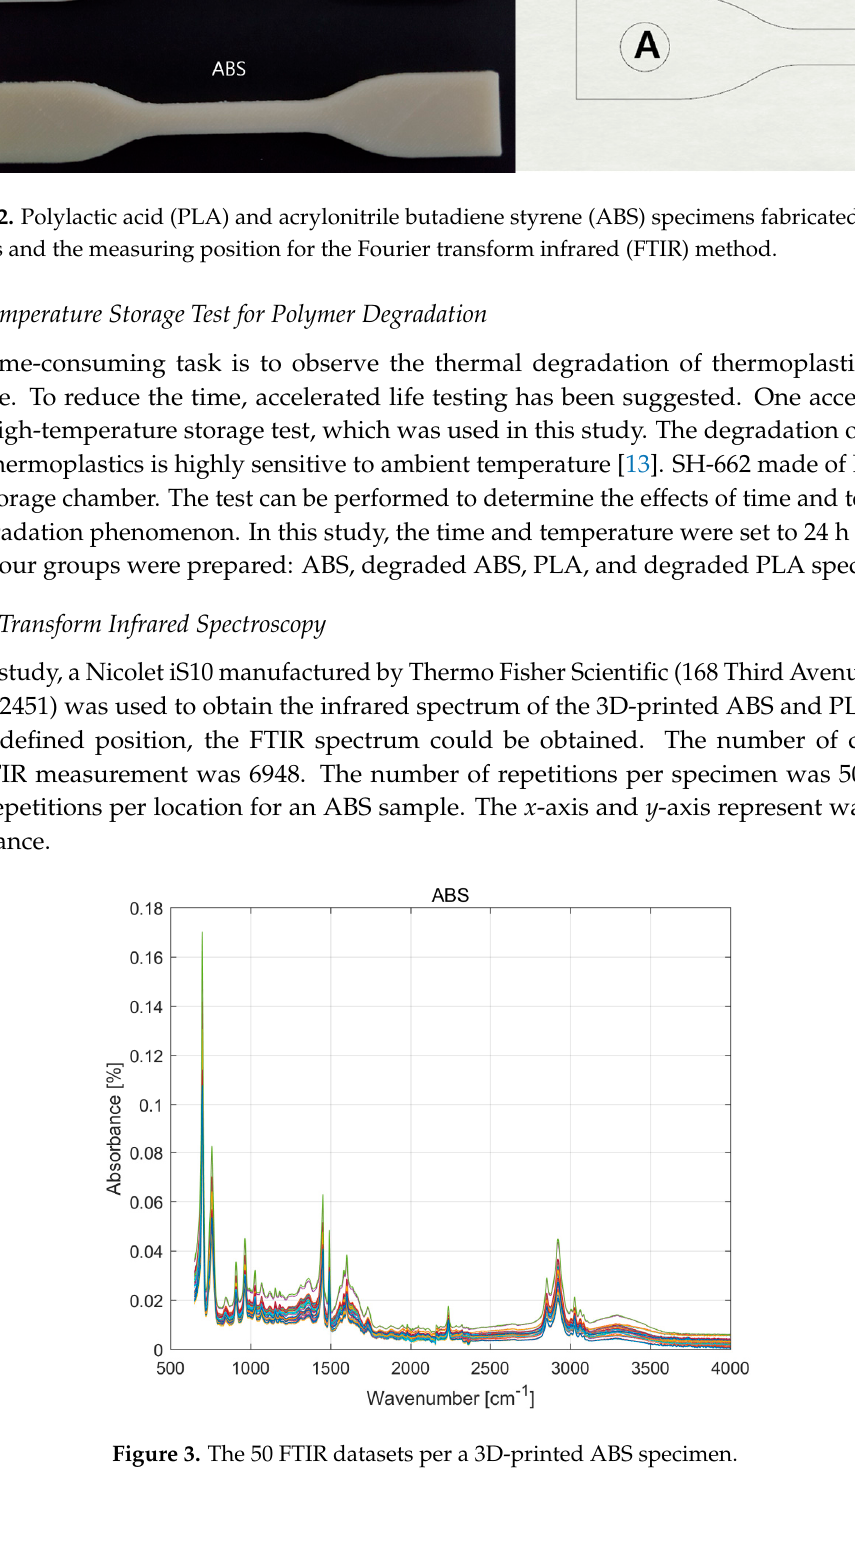
Figure 3. The 50 FTIR datasets per a 3D-printed ABS specimen.